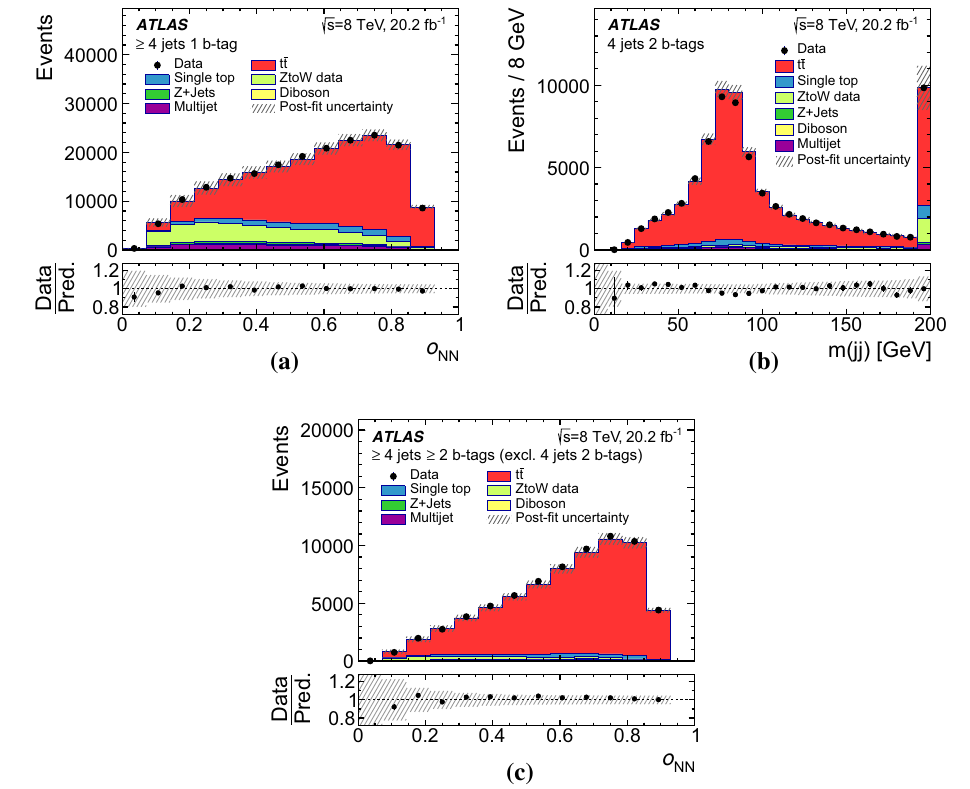
Fig. 6 Neural network discriminant o NN or the m ( jj ) distribution nor- malised to the result of the maximum-likelihood fit for a SR1, b SR2, and c SR3. The hatched error bands represent the post-fit uncertainty.